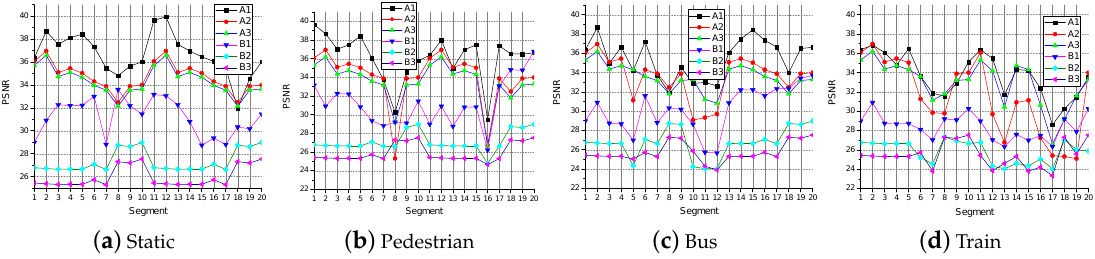
Figure 6. The PSNR in different network environments.